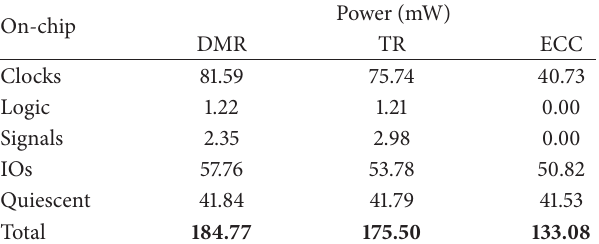
Table 2: Results shown by XPower